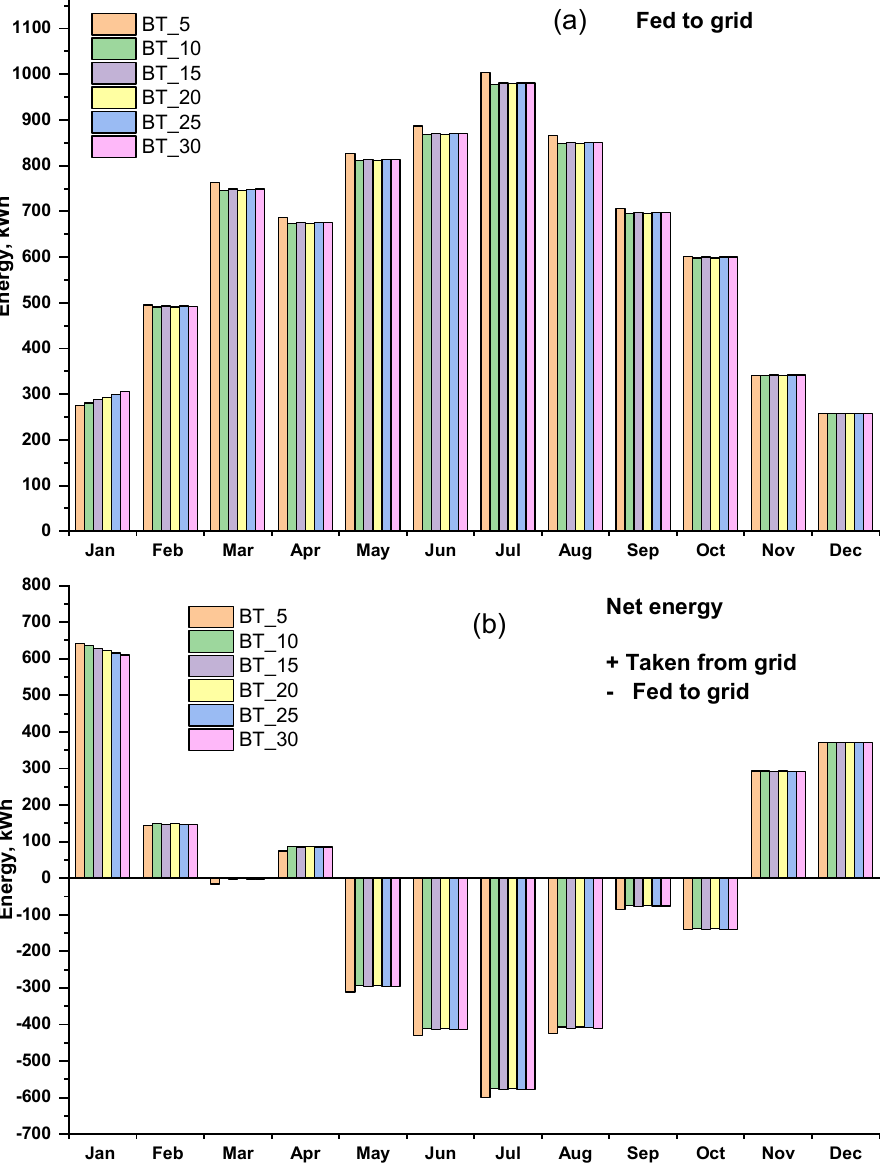
Figure 11. Monthly energy flows: ( a ) energy fed to the grid, ( b ) net energy. Determining the battery bank capacity that can provide the optimal self-sustainability for daily energy distribution is very difficult; however, this task is essential from a microgrid system point of view. Figure 12 shows the annual self-consumption of energy, with the highest energy value reaching 16,117.18 kWh at a rate of 90.19% at BT- 35.